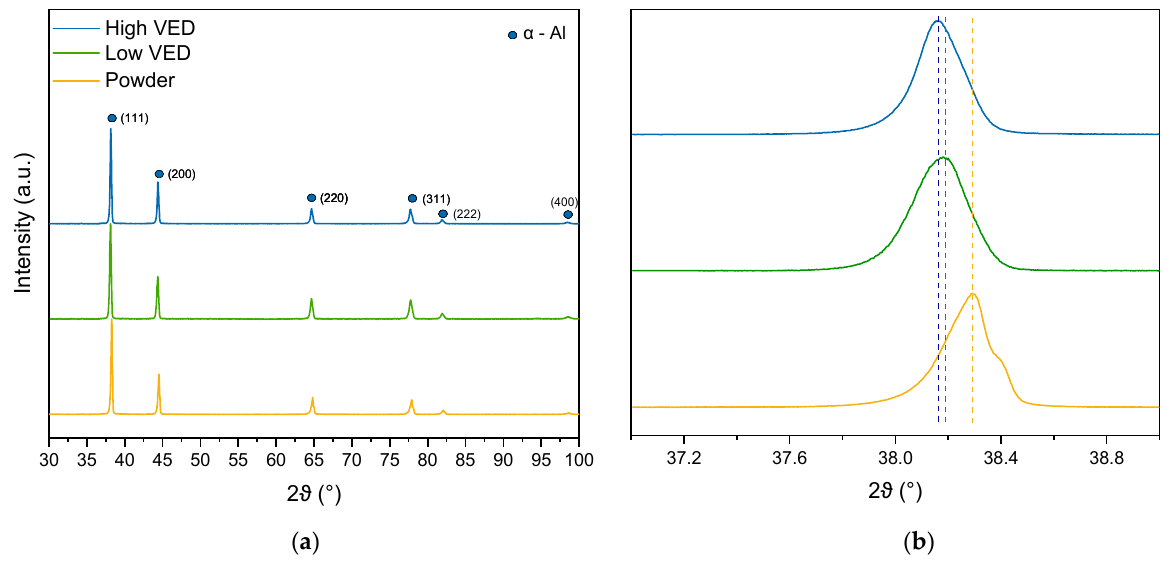
Figure 3. The complete XRD patterns of the raw powder, low- and high-VED as-built samples ( a ) and detailed analysis conducted on the (111) peak ( b ).